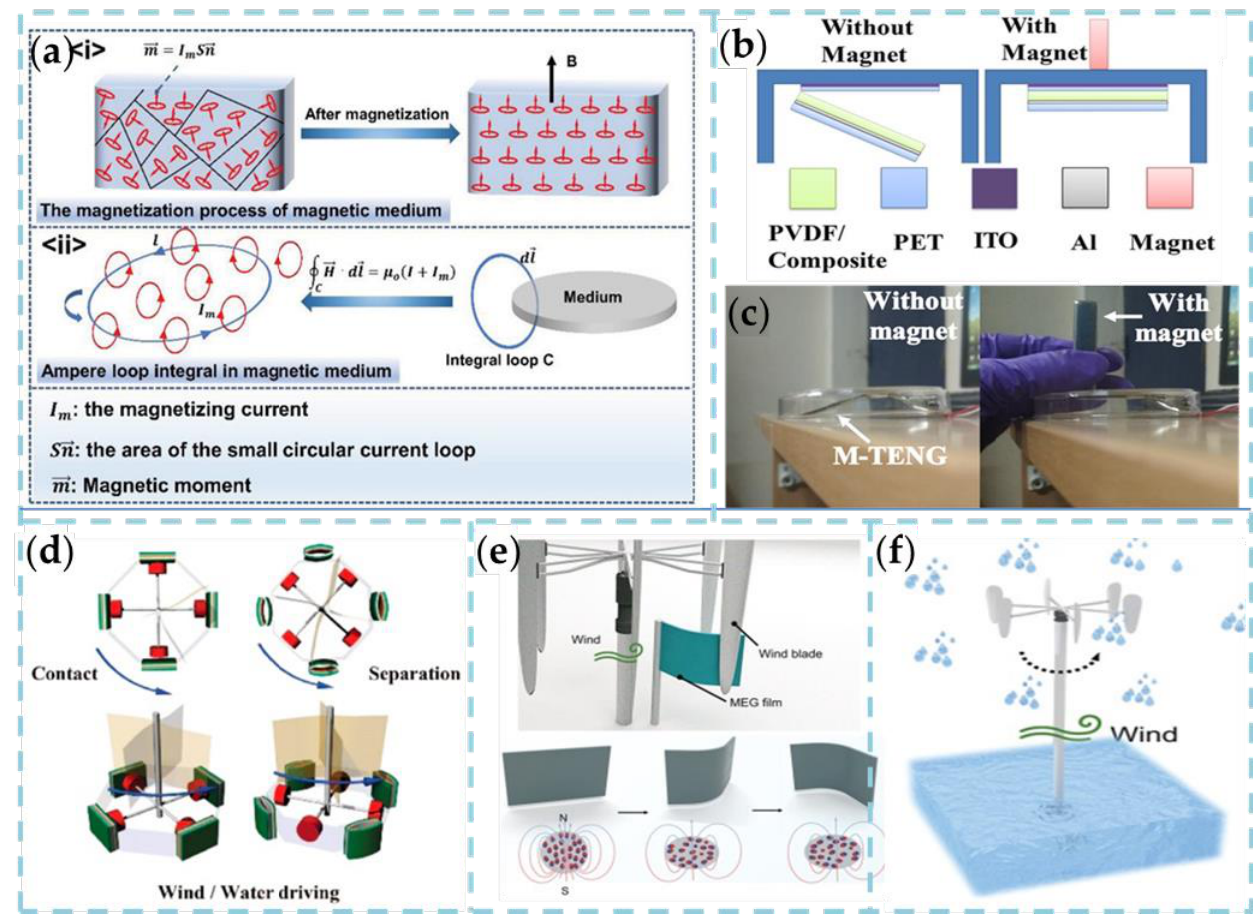
Figure 3. ( a ) The proposed enhancement mechanism of ferromagnetic-based S-TENG []. Copyright 2021, Wiley-VCH. ( b , c ) Schematic of M-TENG structure, with and without magnet and response of magnetic nanocomposite layer with and without magnet [69]. Copyright 2019, AMER CHEMICAL SOC. ( d ) Demonstration and schematic illustration of magnetic-assisted noncontact TENG for harvesting energy from wind and water flow (four devices arranged with perpendicular angles [70]. Copyright 2016, ELSEVIER. ( e ) A further detailed schematic of the zoomed-in wind blade and the correct corresponding wind rotation. The MEG can be seen on the right in its compressed state. ( f ) Schematic demonstration of the wind initiating the process of the generator [71]. Copyright 2022, WILEY-VCH VERLAG